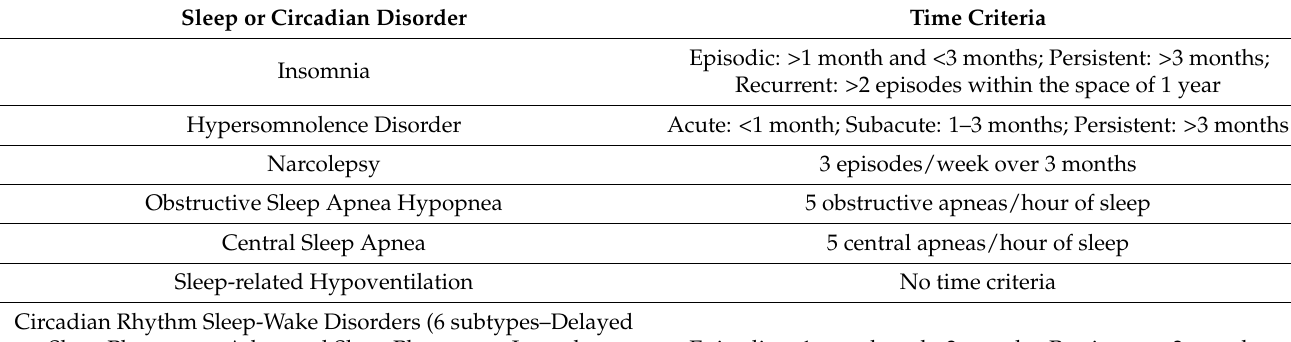
Table 2. DSM-V Time Criteria for Sleep and Circadian Rhythm